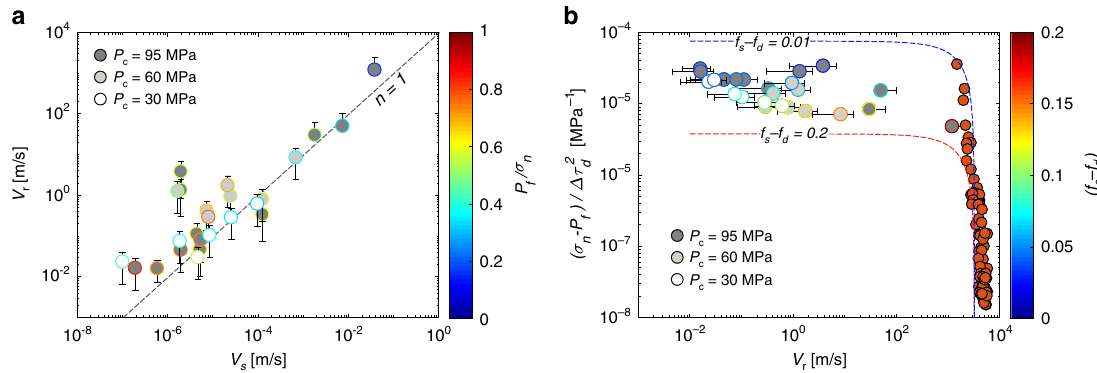
Fig. 6 Control of the nature of the seismicity. a Scaling relation between the rupture velocities and the slip velocities reached during each slip event. White, grey and dark grey correspond to slip events observed at 30, 60 and 95 MPa con fi ning pressures, respectively. The colour bar displays the ratio between the average fl uid pressure and the average normal stress along the fault at the onset of the slip events. b In fl uence of the stress parameters derived from Eq. (9) on the rupture velocity achieved during slip events. White, grey and dark grey symbols correspond to slip events observed at 30, 60 and 95 MPa con fi ning pressures, respectively. Red symbols correspond to dry experiments conducted on Westerly granite 38 . Blue and red dashed lines correspond to LEFM predictions using strength drops of 0.01 and 0.2,